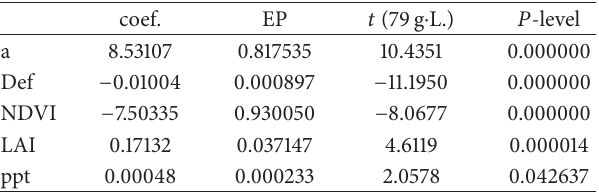
Table 5: Values (coef.), standard errors of coef. (EP), statistics of Student’s test ( 𝑡 ), probability of significances ( 𝑃 -level) of the equation coefficients for the water deficiency in mm (def.), NDVI, LAI, and precipitation in mm (ppt)